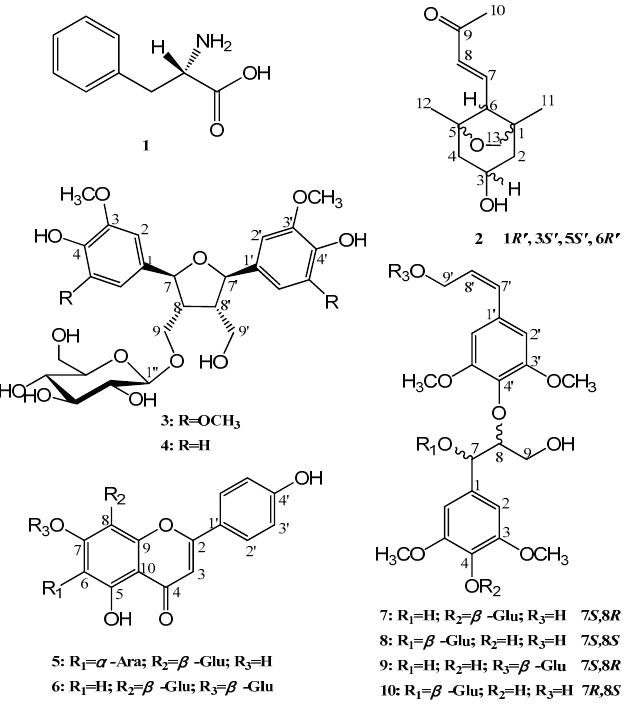
Figure 1. Compounds 1 – 10 isolated from Indocalamus latifolius McClure